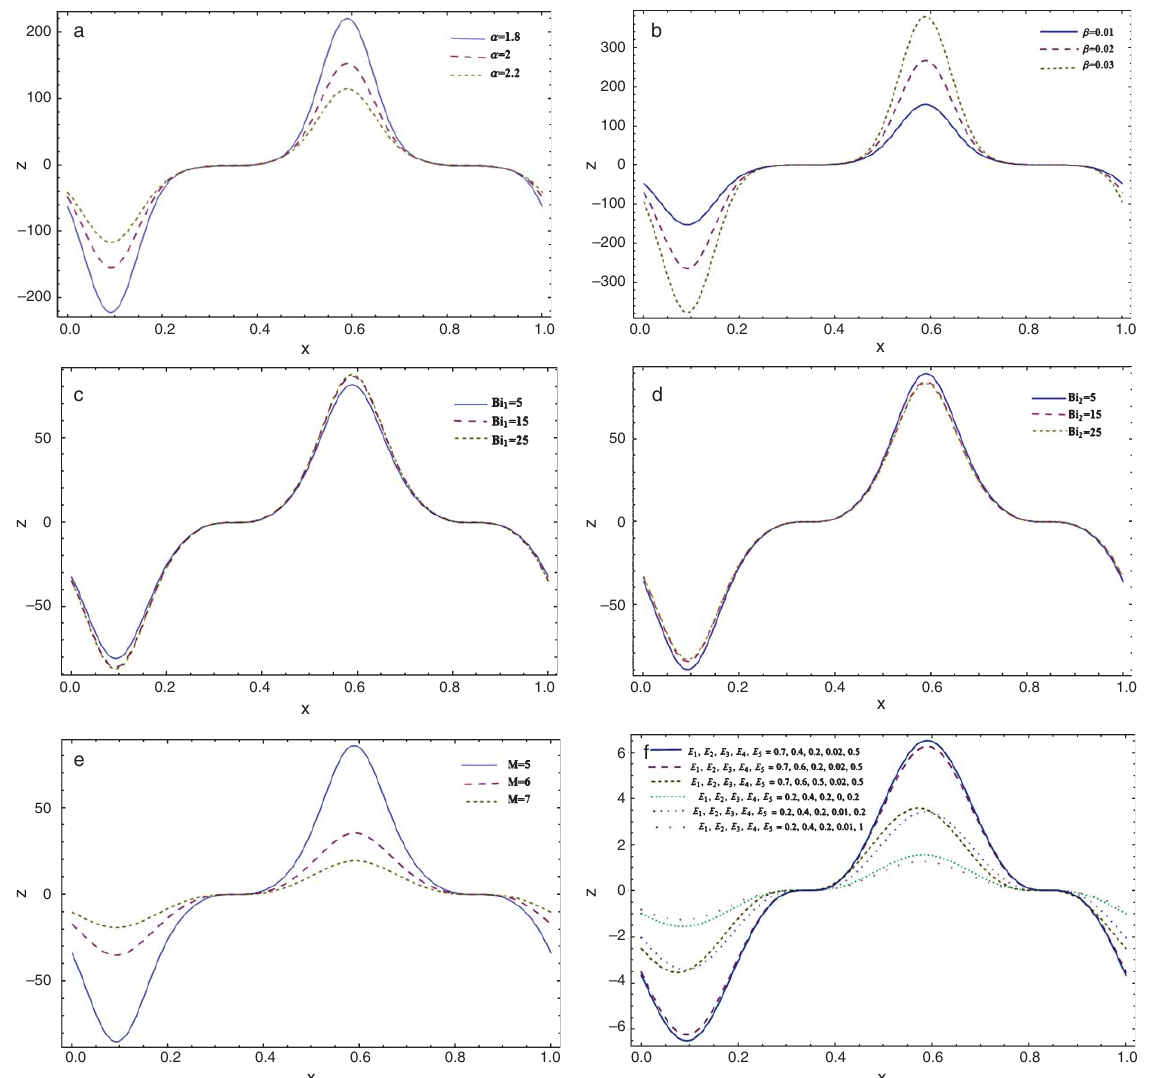
Fig.4. (a):Variationof α on Z when M = 5 ,E 1 = 1 ,E 2 = E 3 = 0 . 5 ,E 4 = 0 . 01 ,E 5 = 0 . 3 ,(cid:11) = 0 . 2 ,t = 0 . 1 ,β = 0 . 01 ,Br = 2 ,Bi 1 = 8and Bi = 10 . (b):Variationof β on Z when M = 5 ,E = 1 ,E = E = 0 . 5 ,E = 0 . 01 ,E = 0 . 3 ,(cid:11) = 0 . 2 ,t = 0 . 1 ,α = 2 ,Br = 2 ,Bi 2 1 2 3 4 5 = 10 . (c):Variationof Bi Z when M = 5 ,E = 1 ,E = E = 0 . 5 ,E = 0 . 01 ,E = 0 . 3 ,(cid:11) = 0 . 2 ,t = 0 . 1 ,β = 0 . 01 ,α = 2 . 5 ,Br = 2 Bi 2 1 on 1 2 3 4 5 and Bi 2 = 15 . (d): Variation of Bi 2 on Z when M = 5 , E 1 = 1 , E 2 = E 3 = 0 . 5 , E 4 = 0 . 01 , E 5 = 0 . 3 , (cid:11) = 0 . 2 , t = 0 . 1 , β = 0 . 01 , Br = 2 and Bi 1 = 10 . (e): Variation of M on Z when E 1 = 1 , E 2 = E 3 = 0 . 5 , E 4 = 0 . 01 , E 5 = 0 . 3 , (cid:11) = 0 . 2 , t = 0 . 1 , β = 0 . 01 , α = 2 . 5,. Br = 2 , = 8and Bi = 10 . (f):Variationofparametersofwallpropertieson Z when M = 5 ,(cid:11) = 0 . 2 ,x = 0 . 3 ,t = 0 . 1 ,β = 0 . 01 ,Br = 2 ,α = 2 . 5 , Bi 1 2 Bi = 8 and Bi = 10 1 2